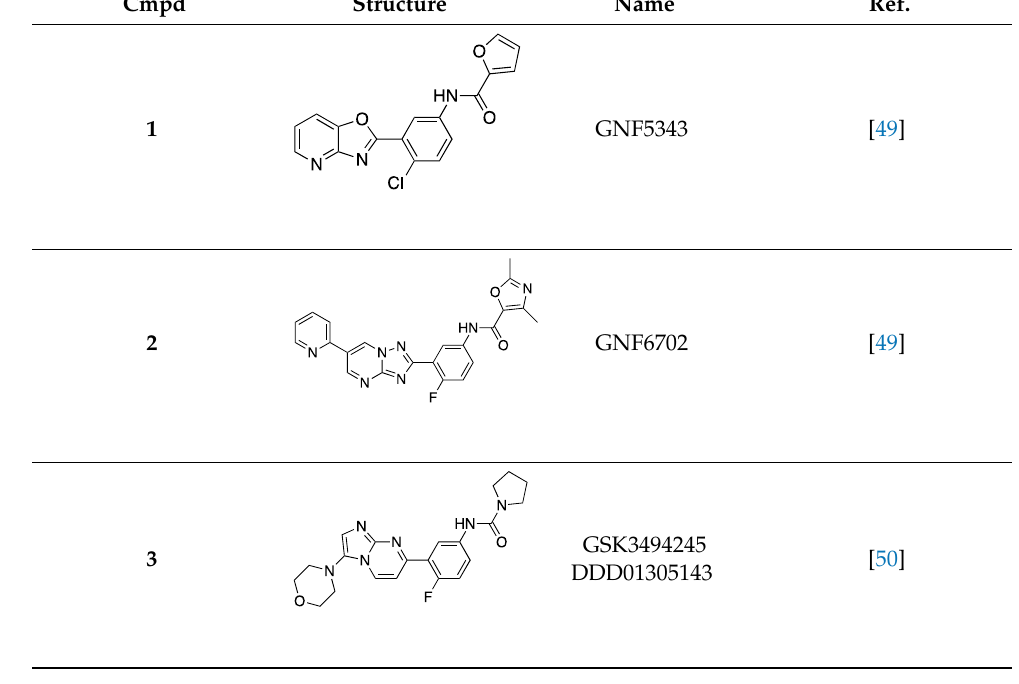
Table 2. Kinetoplastid proteasome inhibitors.